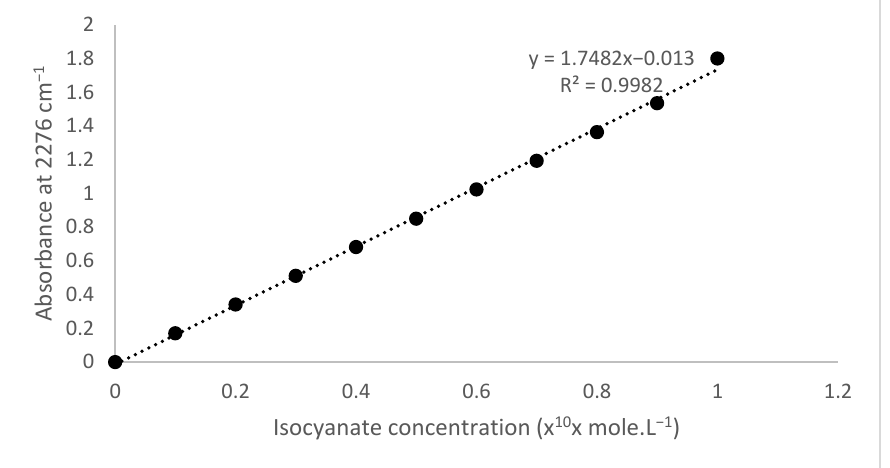
Figure 4. The isocyanate calibration curve based on TDI spectra. The diazene solution concentration was analyzed by plotting the infrared absorbance at a wavelength of 1768 cm −1 and extrapolation to the diazene calibration curve. Quantitative infrared spectroscopy analysis used a standard liquid cuvet sampler for the Prestige FTIR diameter of 1 cm. The conversion of the absorbance to the concentration used the Beer law, where the spectra’s absorbance was linear to their concentration if the other parameters were constant. The diazene calibration curve is illustrated in Figure 5, and shows that the absorbance value was linear to their diazene concentration and is expressed by equation Abs = 16.066 CNCO − 0.1247 with an R 2 value =